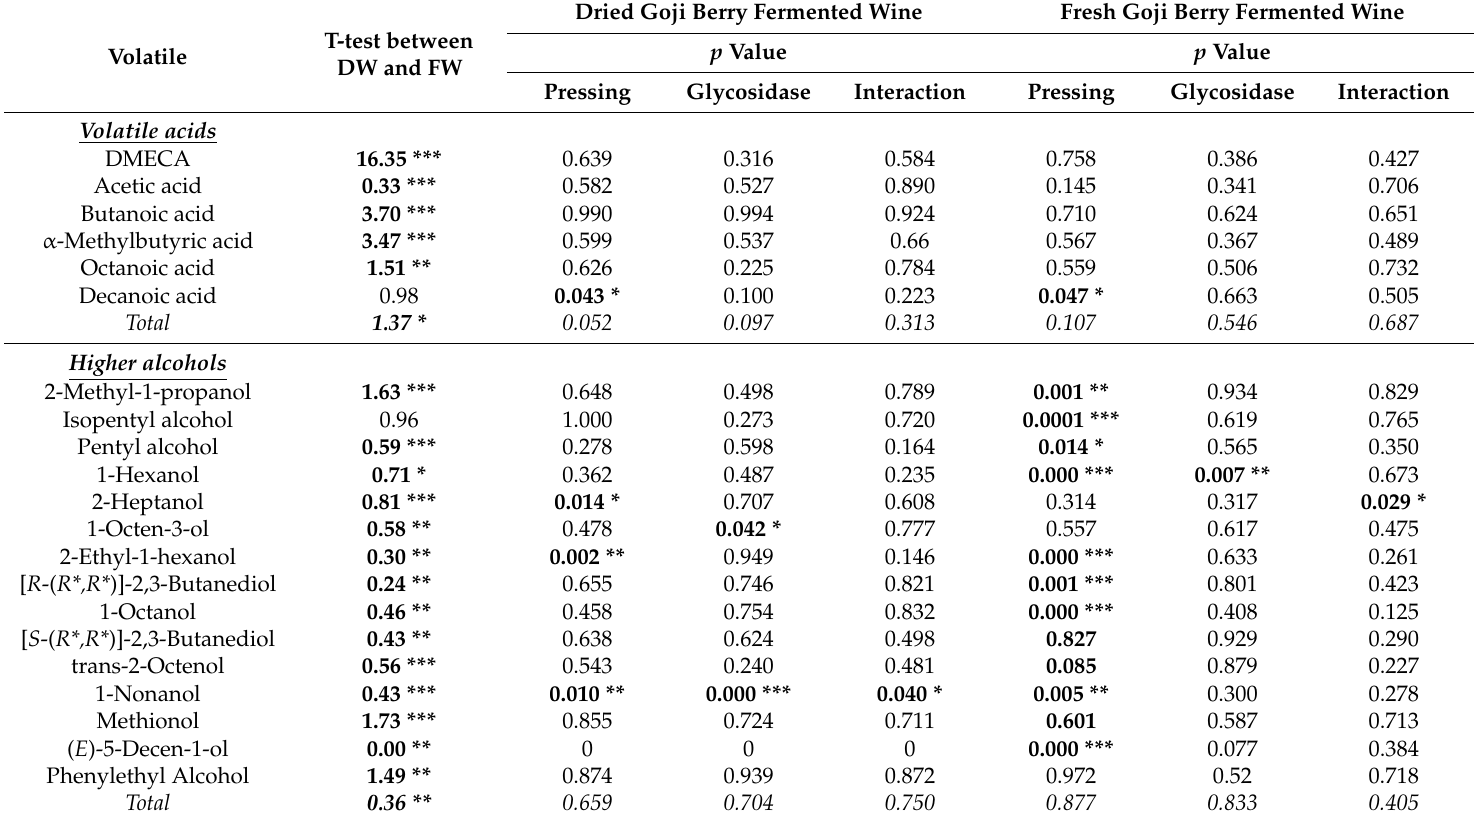
Table 4. T-test on concentration of volatile compounds in wine made of fresh and dried berry fruit and two-factor variance analysis on concentration of volatile compounds in goji berry fermented wine with pressing and glycosidase